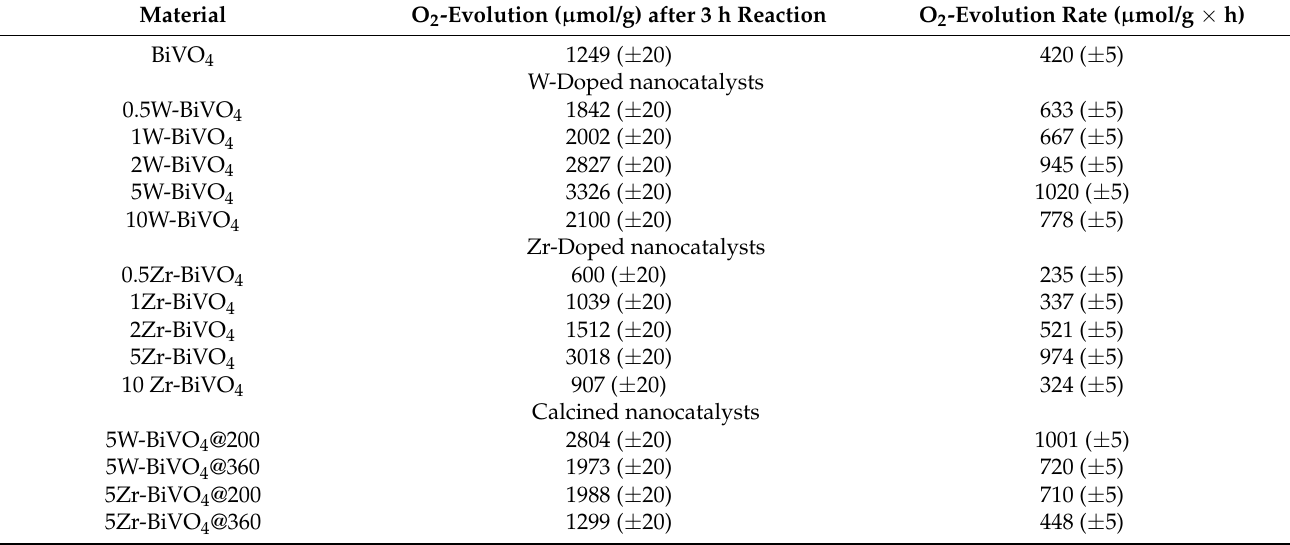
Table 2. O 2- evolution by the present FSP-made BiVO 4 -based photocatalysts.